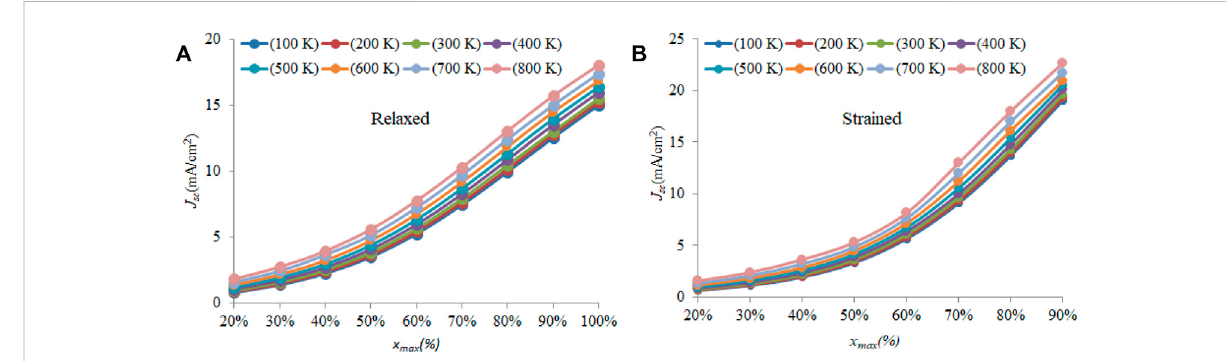
FIGURE 10 J sc for both (A) relaxed and (B) strained conditions at different temperatures for different x max .